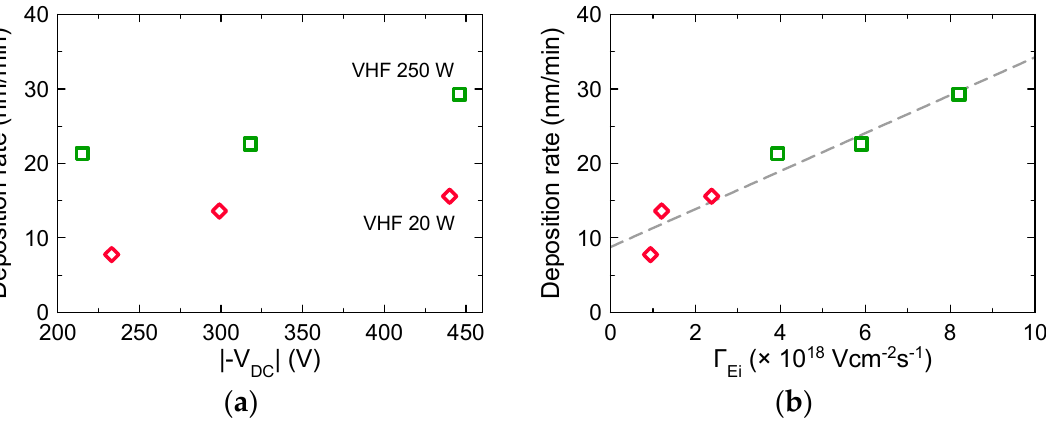
Figure 4. Deposition rate as a function of ( a ) magnitudes of negative self-bias voltages (|- V DC |) and ( b ) ion bombardment energy fluxes. Diamonds ( ◇ ) and squares ( □ ) correspond to 20 and 250 W in VHF power, respectively.